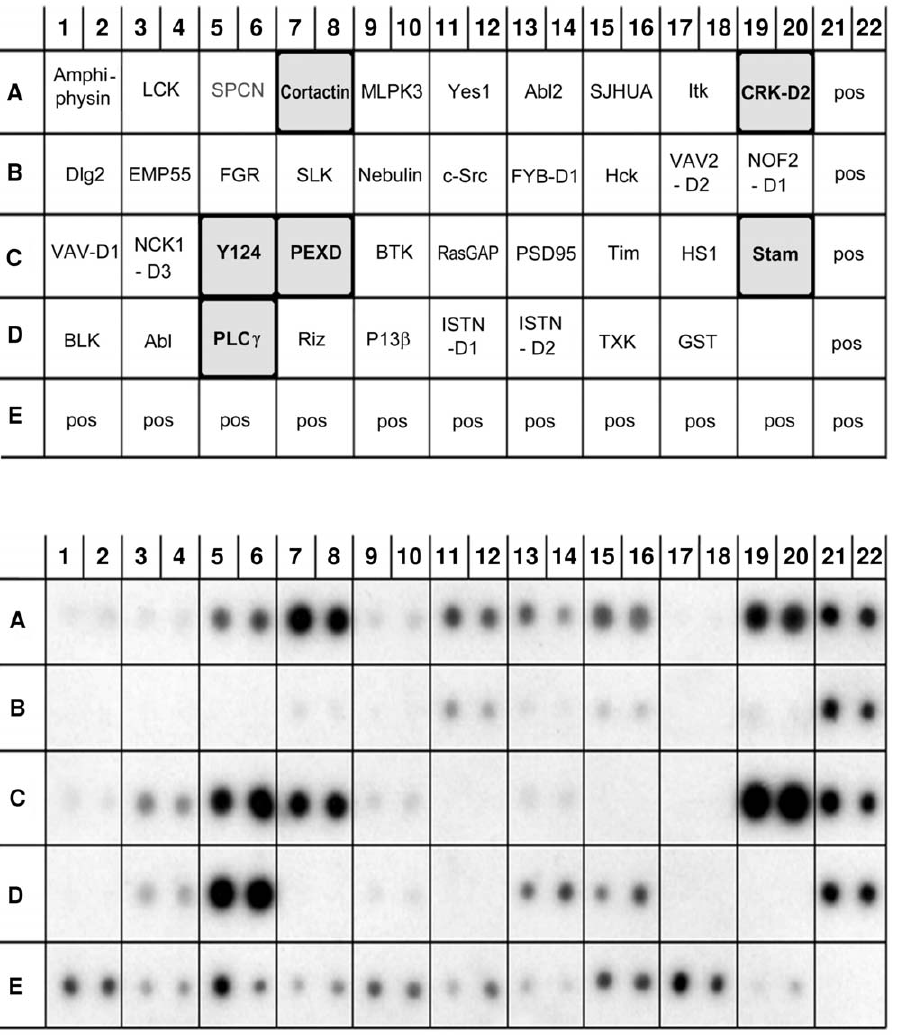
Figure 3. Ankrd2 can interact with proteins containing SH3 domains. A SH3 protein array (Panomics/Affymetrix, USA) was probed with His- tagged Ankrd2 protein (15 m g/ml). The upper panel is a schematic diagram of the array showing the positions of the spotted GST-proteins; proteins positive for interaction with Ankrd2 are highlighted. The lower panel shows the membrane after hybridization with His-Ankrd2 protein. Ankrd2 bound strongly to the following SH3 proteins: Cortactin, CRK-D2, Y124, PEXD, Stam, and PLC c . The positive controls (in duplicate) intended for alignment are seen at the bottom and the right edge of the blot.